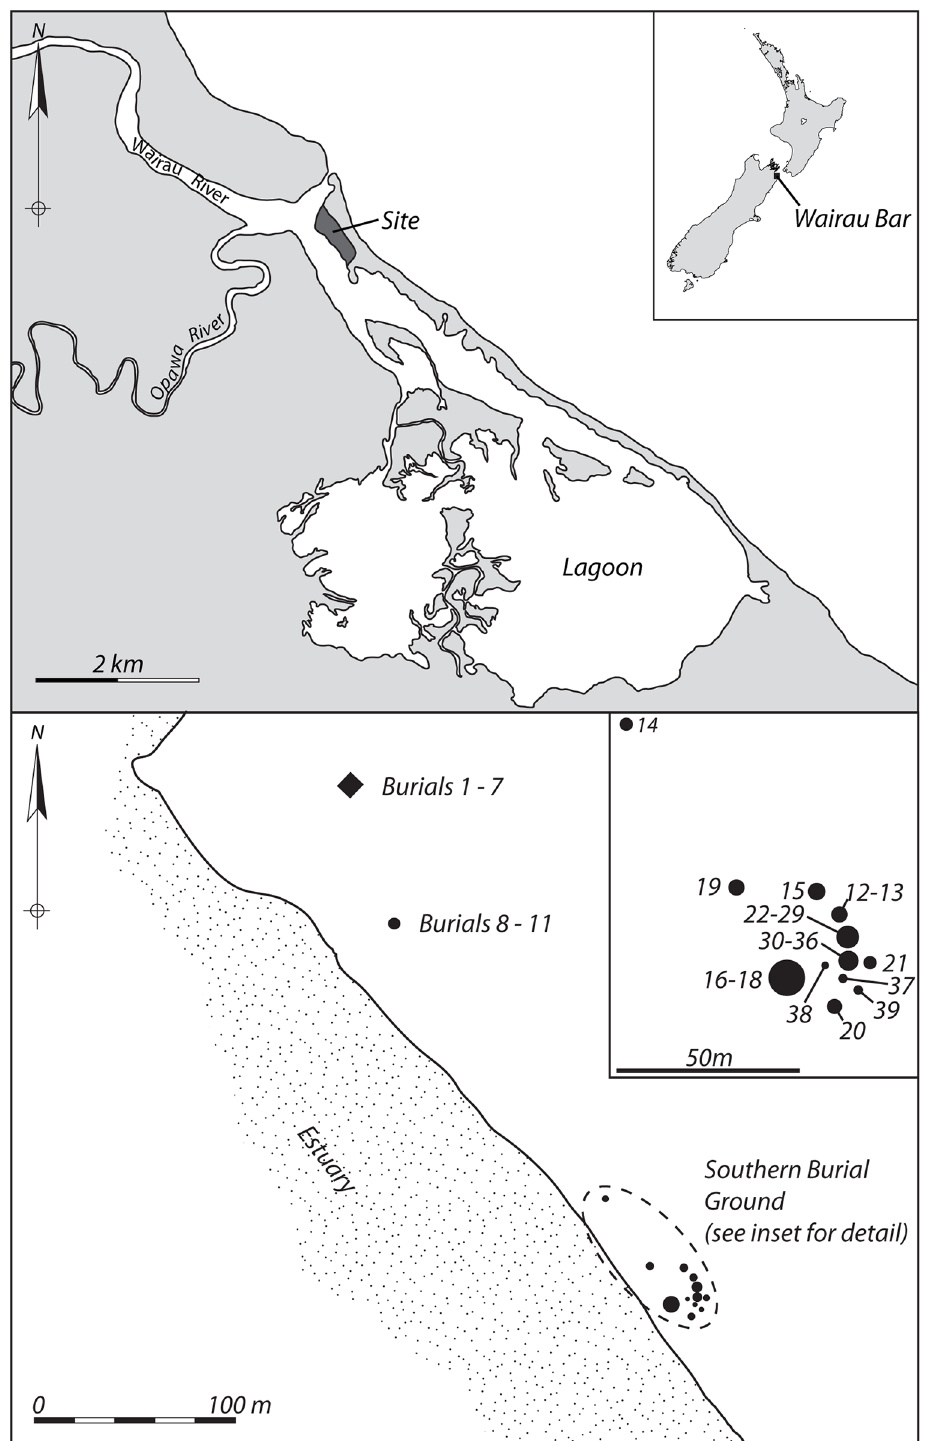
Fig 1. Location of the Wairau Bar site and the burial groups. Map and burial location information adapted from Brooks et al . 2011).